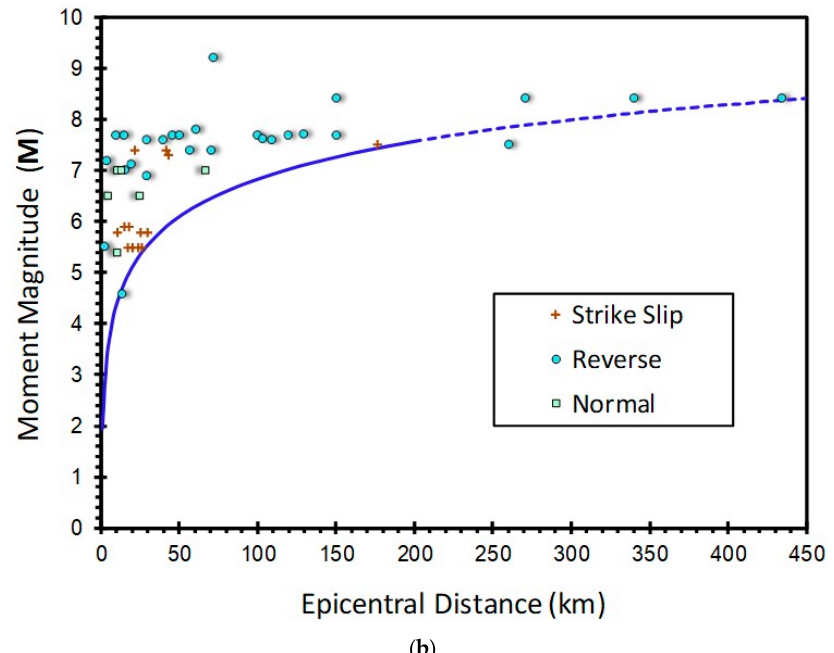
Figure 20. Empirical relations between moment magnitude, M, and distance to farthest surface expression of liquefaction. ( a ) Relation between magnitude and fault distance, as well as epicentral distance of liquefaction (after Reference [195]). ( b ) Relation between magnitude and epicentral distance to farthest known sand blows that formed during earthquakes produced by strike slip, reverse, and normal faulting (after Reference [181]).